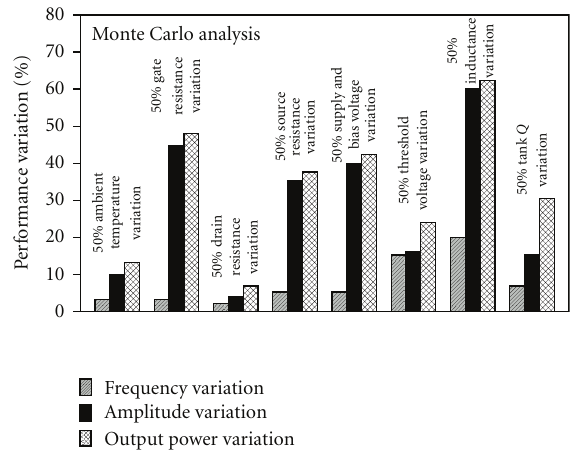
Figure 13: Bar chart of overall temporal Monte Carlo simulations for manufacturability for 50% variation in the process, circuit, and environmental parameters.